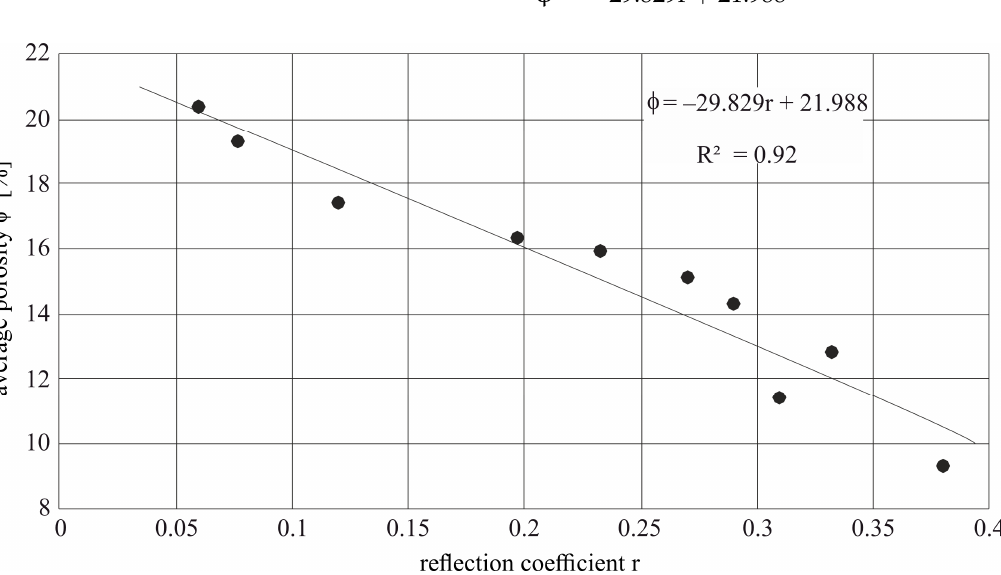
Figure 10. Relationship between average porosity calculated from several boreholes and reflection coefficients from the top of carbonate deposit at their location.